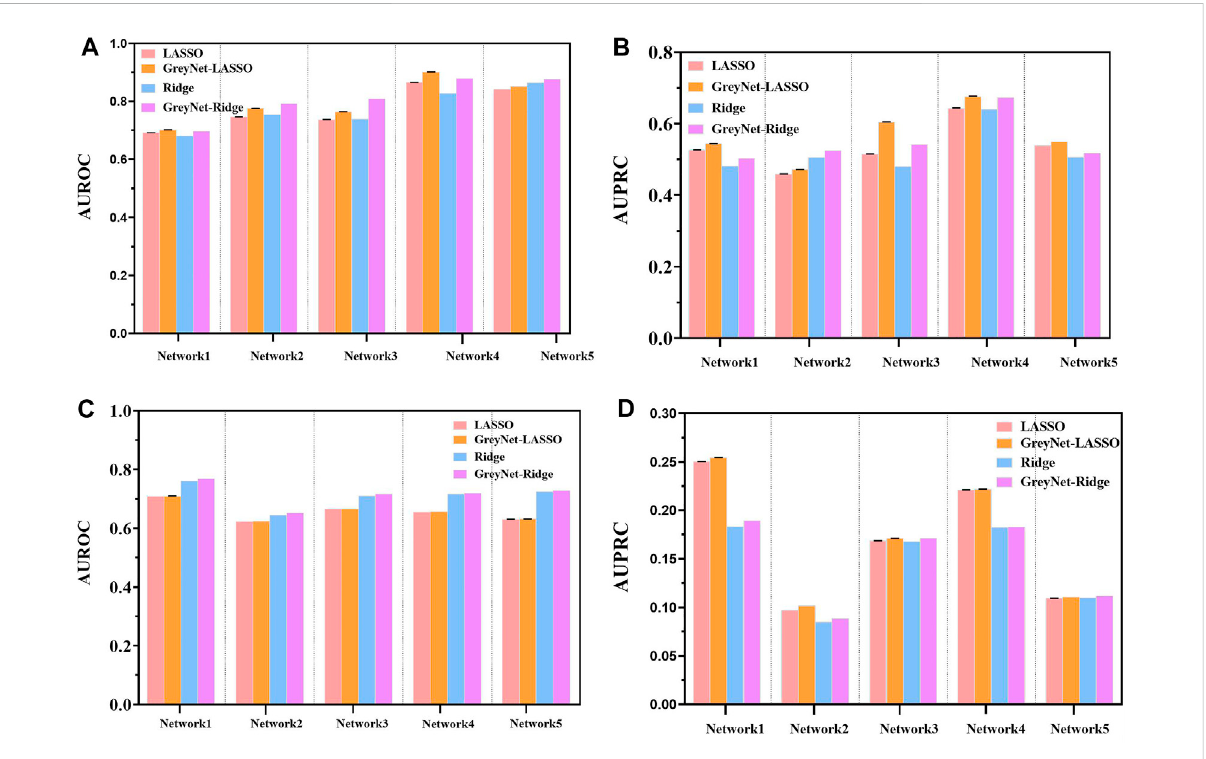
FIGURE 3 The comparison of LASSO, GreyNet-LASSO, Ridge, and GreyNet-Ridge on DREAM4 in in silico datasets. (A) is the results of AUROC on size10 networks. (B) is the results of AUPRC on size10 networks. (C) is the results of AUROC on size100 networks. (D) is the results of AUPRC on size100